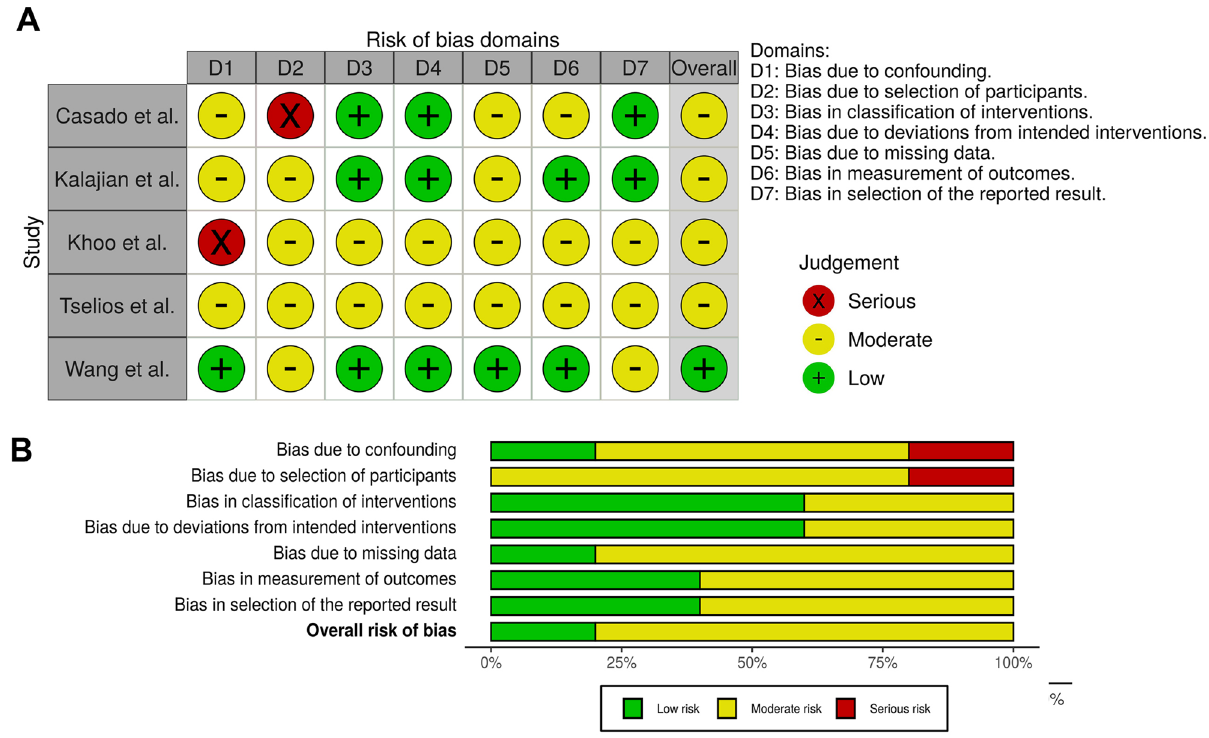
Figure 3. ( A ) Bias domains in ROBINS-I for included studies. ( B ) Total Score for each domain